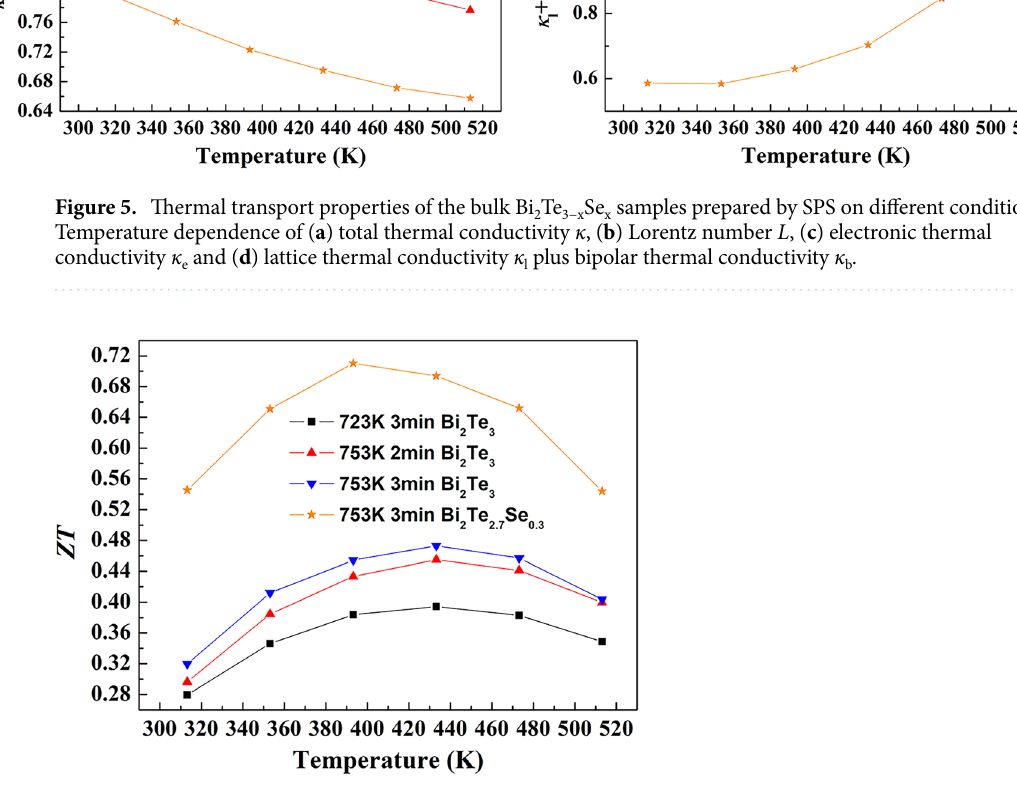
Figure 6. Temperature dependence of ZT values of the bulk Bi 2 Te 3−x Se x samples prepared by SPS on different